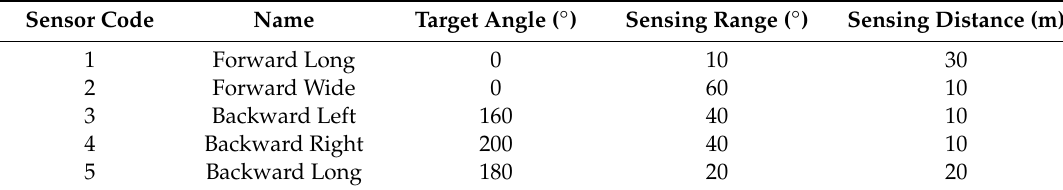
Table 1. Radar configuration of Connected and Autonomous Probes.